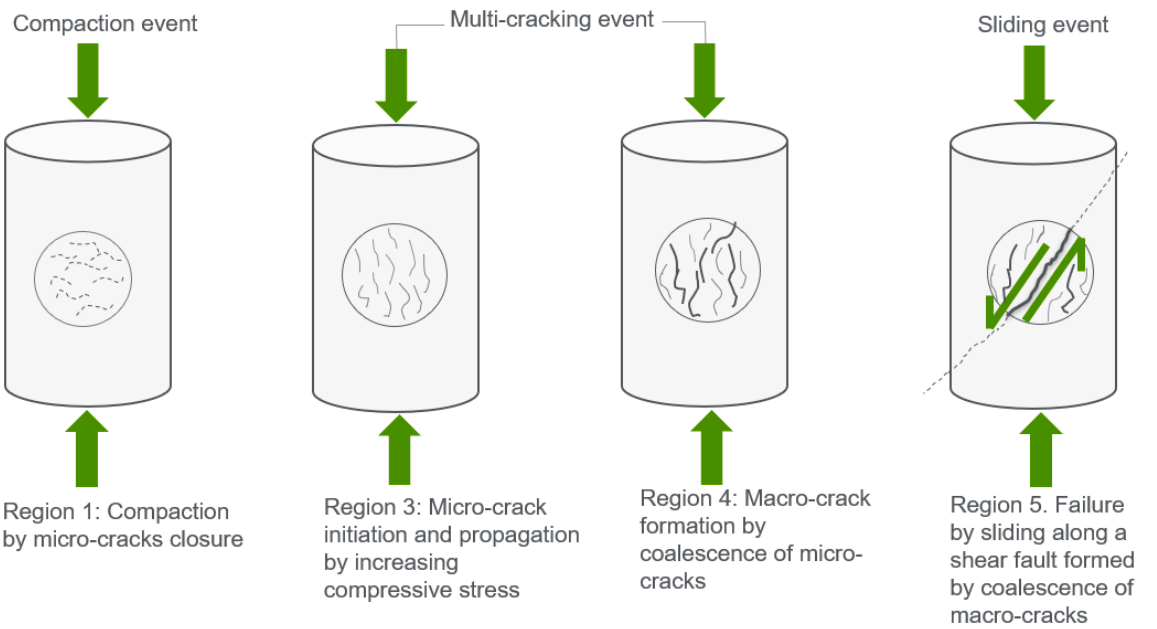
Figure 4. Schematic diagram of distinct events/regions during deformation of a rock/concrete specimen.